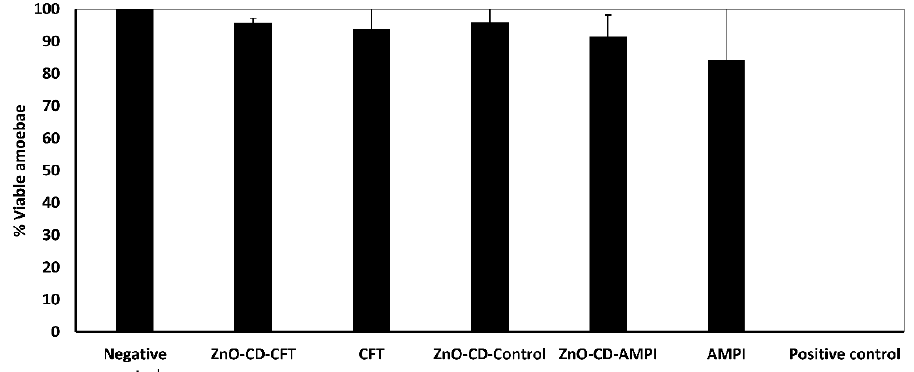
Figure 1. The amoebicidal activity of the compounds was investigated. After a 24 h incubation period, all compounds showed no amoebicidal effects of significance at the concentration of 100 µ g/mL. The results are presented as the mean ± standard error.